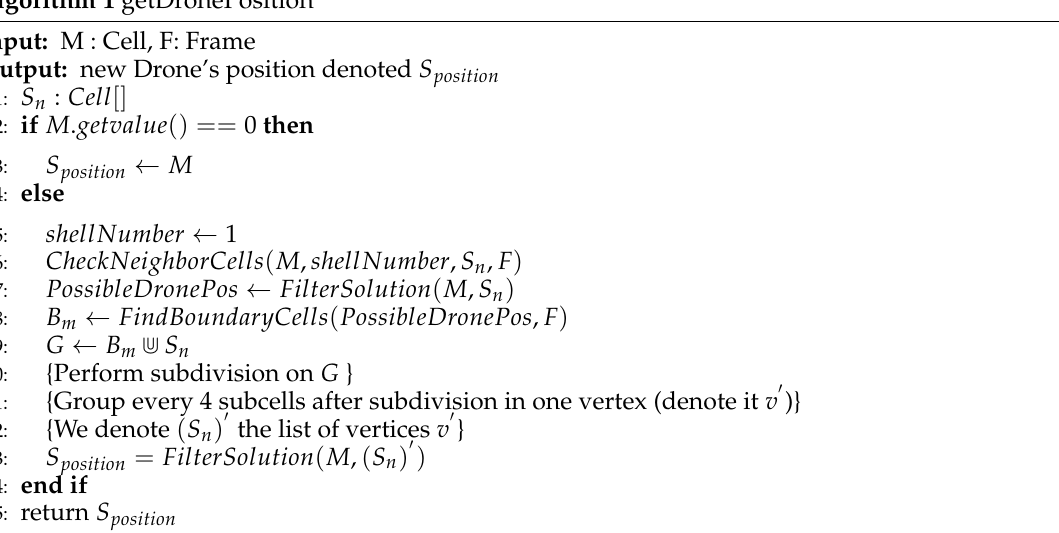
Algorithm 2 ( CheckNeighborCells ) looks for the list of possible solutions S n around M in the surrounding shells in a spiral mode starting from M. The list of solutions is filtered by Algorithm 3 ( FilterSolution ) to choose the nearest possible solution cell S (cid:48) to M which could be the next drone’s